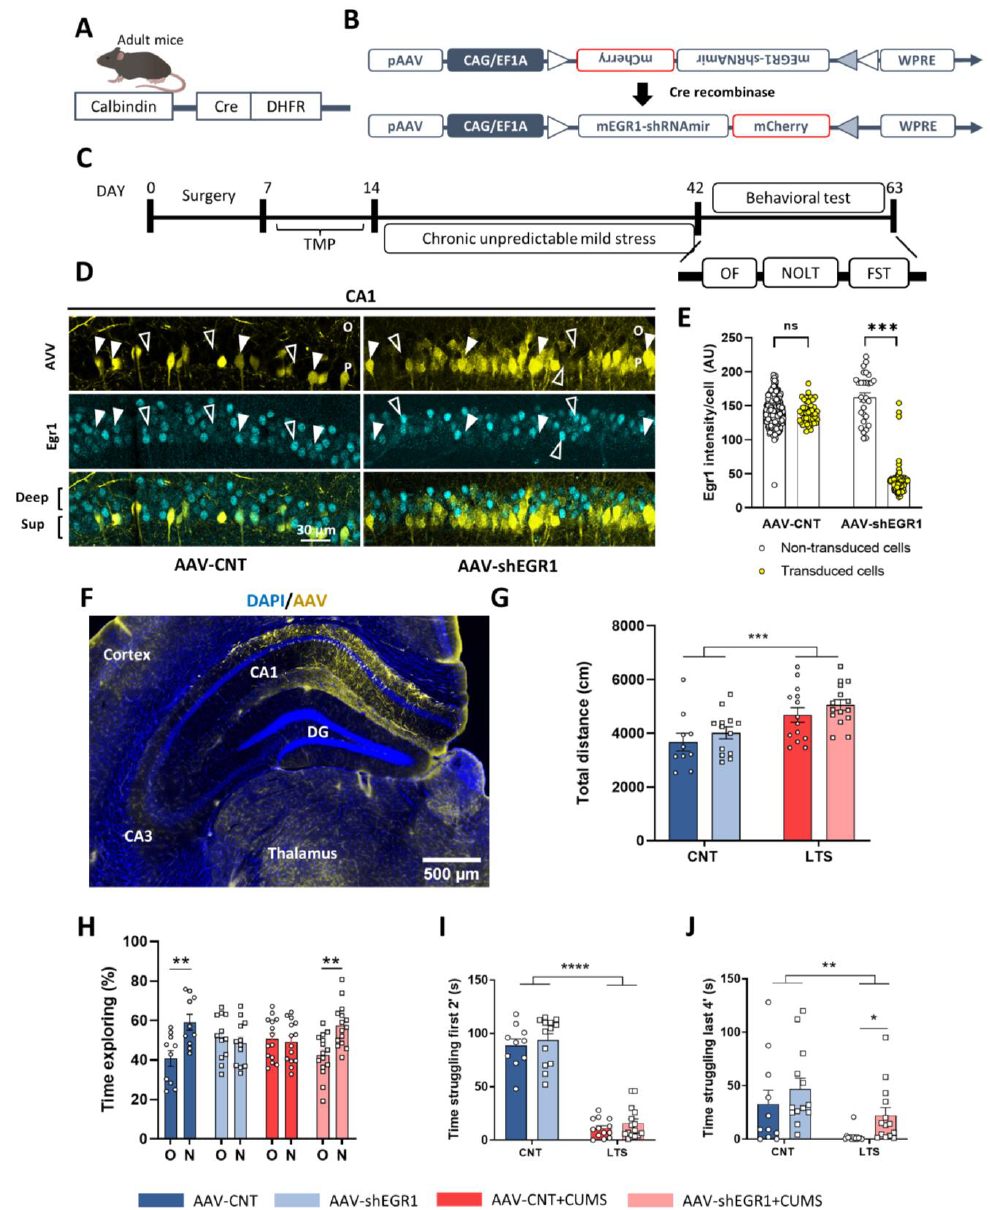
Figure 5. Effects of Egr1 shRNA delivery in CA1 superficial pyramidal neurons during CUMS. ( A ), Schematic representation of the calbindin-Cre mice. ( B ), Schematic diagram showing the AAV-